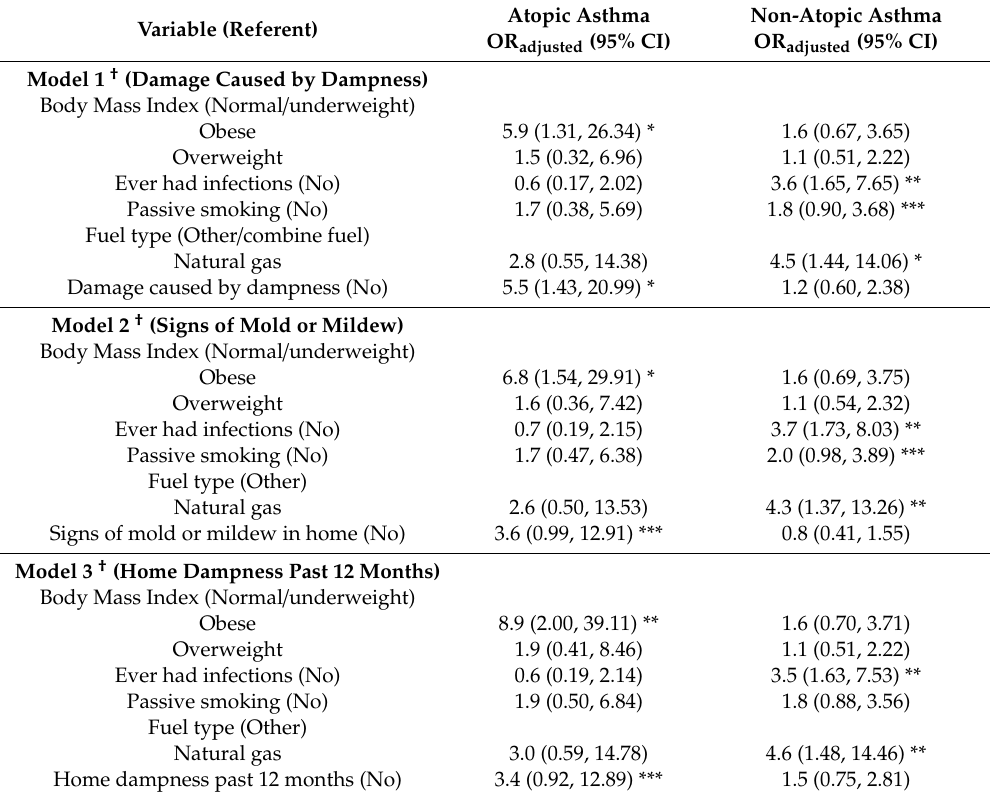
Table 3. Multivariate multinomial logistic regression model results (odds ratio (OR) and 95% confidence intervals (CI)) assessing damp housing characteristics for atopic and non-atopic asthma (reference to no